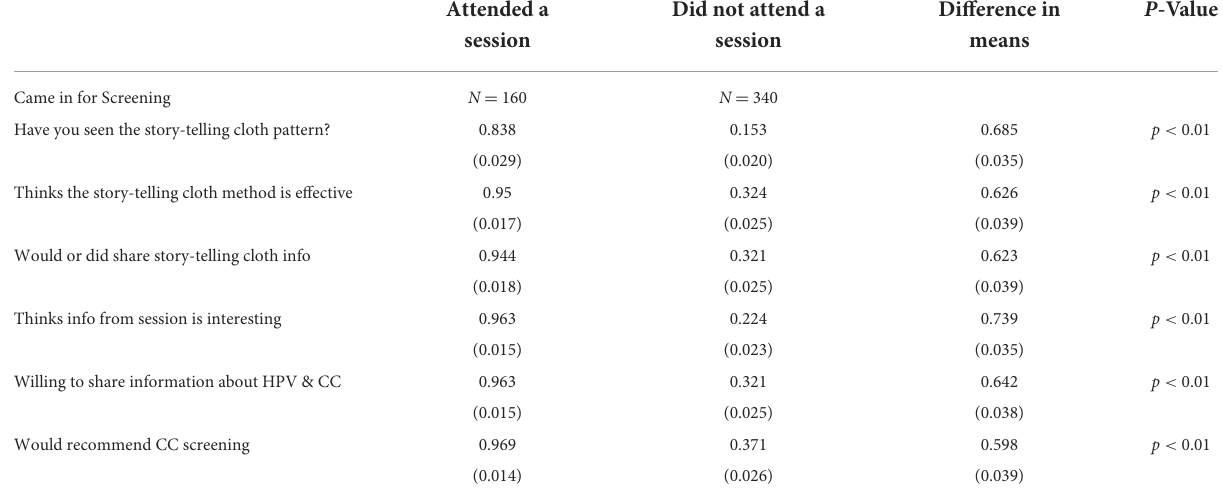
TABLE 5 Difference in means